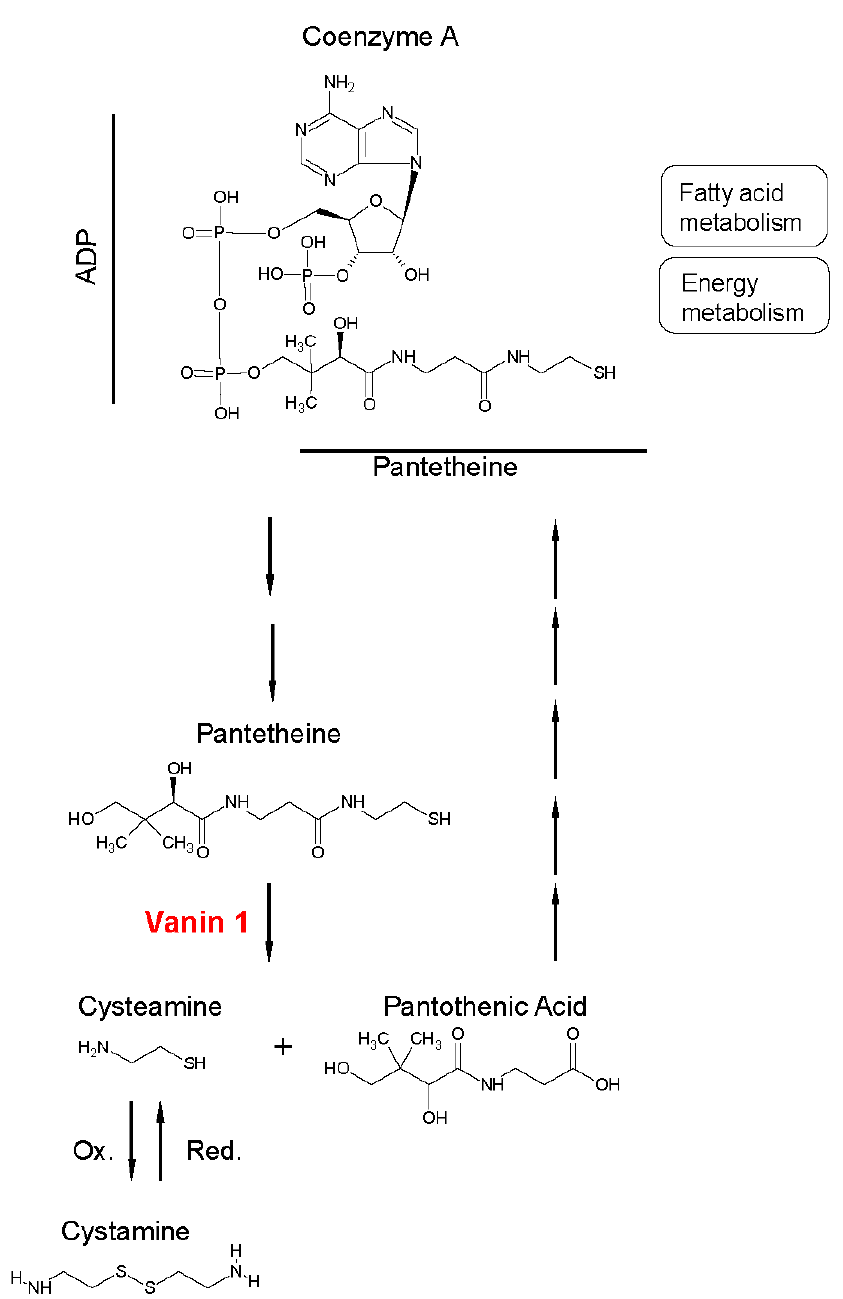
Figure 1. Schematic overview of vanin 1 ′ s enzymatic activity. Vanin 1 ′ s substrate is pantetheine, which makes up the structure of coenzyme A (CoA), together with adenosine diphosphate (ADP). The enzyme catalyzes the hydrolysis of pantetheine into pantothenic acid and cysteamine, which in turn can be oxidized (Ox.) to cystamine. Pantothenic acid can be recycled as a precursor of CoA after five biochemical reaction steps (symbolically represented by five arrows).